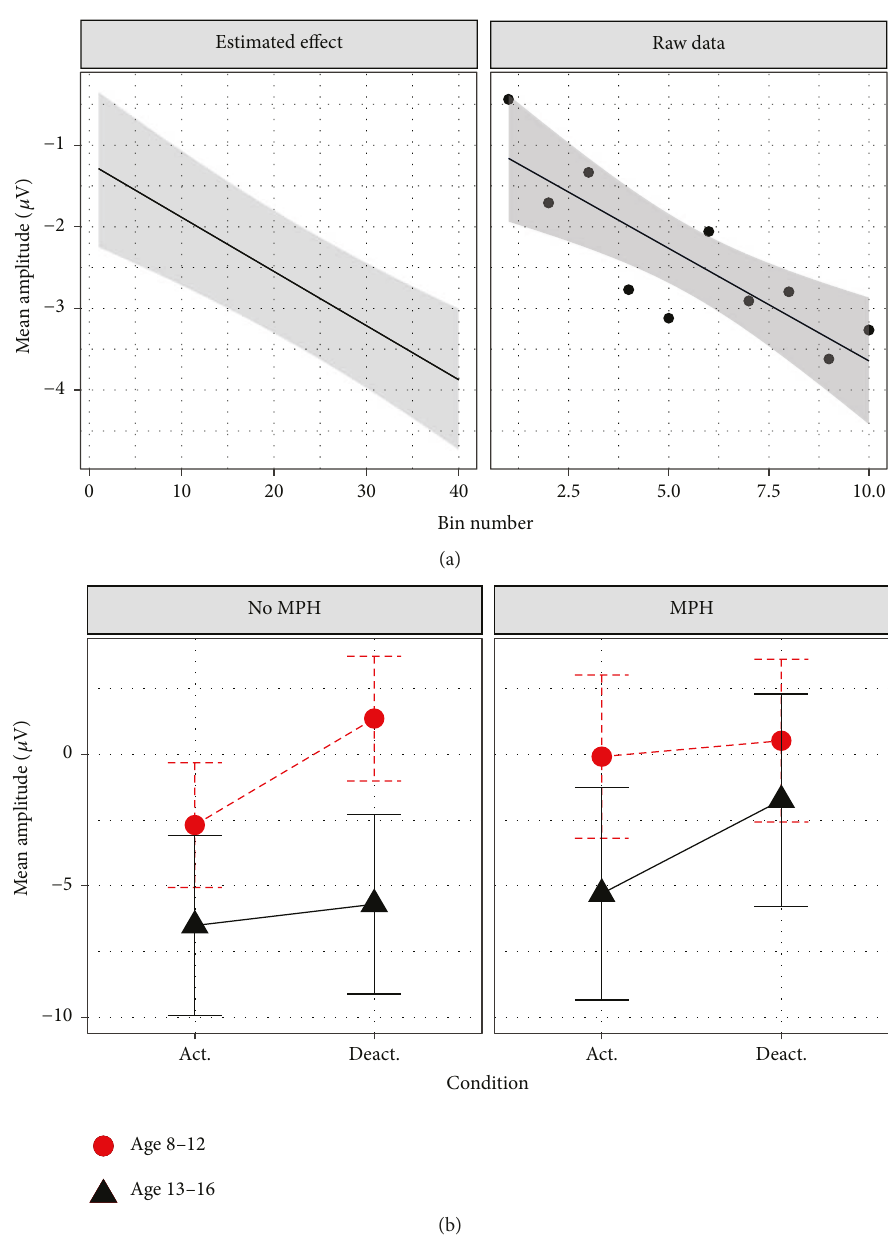
Figure 4: Visualization of e ff ects moderating within-session NF learning in the feedback condition. The dependent variable is mean amplitude ( μ V) of baseline-corrected trials. (a) E ff ect plot for the e ff ect bin number. For comparison between e ff ect and raw data, see scatter plot in the right panel. Bin number: trials of all sessions were averaged and subdivided into ten equally spaced units. For visualization age is subdivided into two age classes (8 – 12 and 13 – 16 years), but preserved as a continuous variable in the original model. (b) E ff ect plot for the interaction between MPH, age, and task. Act.: activation task. Deact.: deactivation